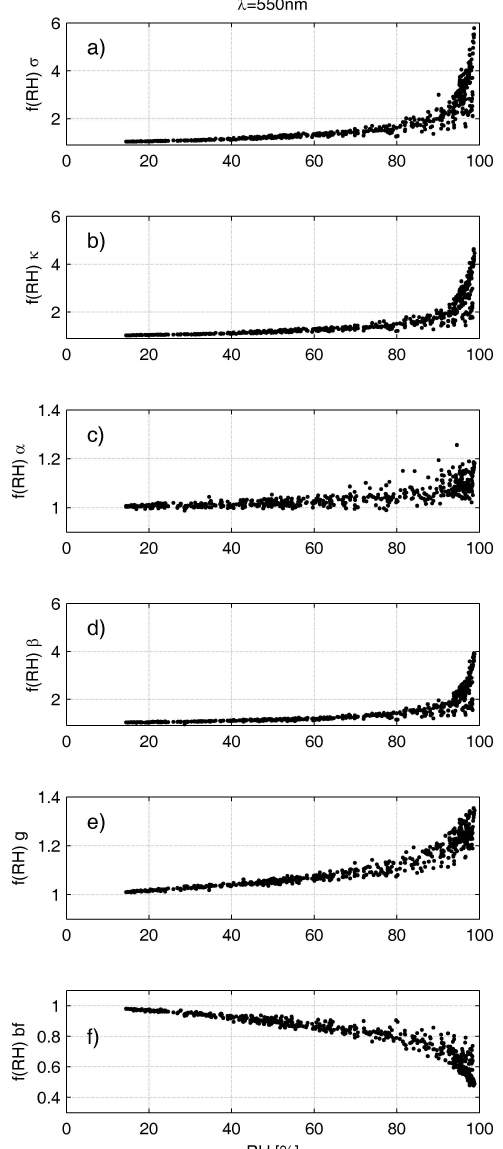
Fig. 7. Enhancement factors for aerosol scattering (a) , extinction (b) , absorption (c) and backscatter (d) coefficients, asymmetry pa- rameter (e) and backscatter fraction (f) at 550nm.